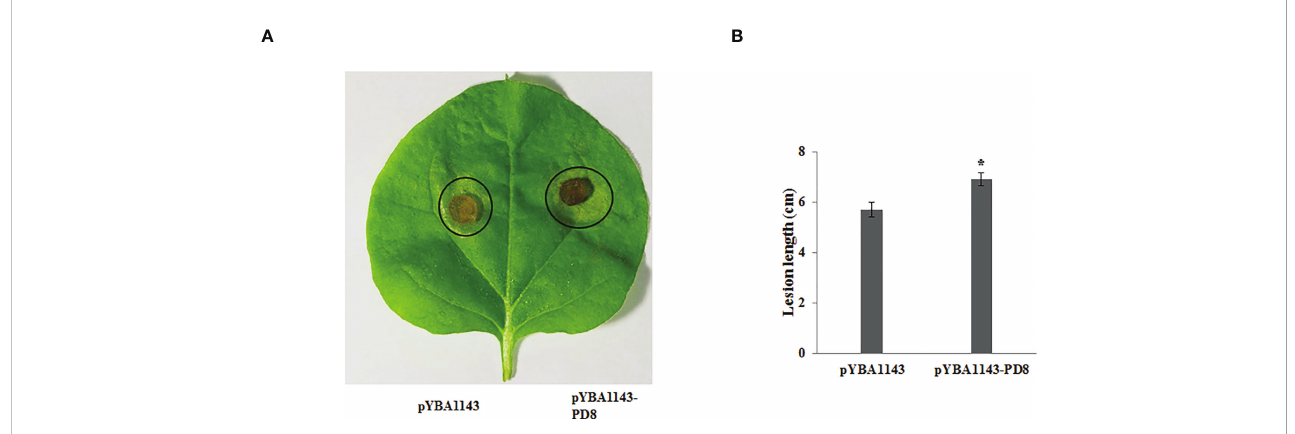
FIGURE 5 Over-expressing PD8 lead to enhanced susceptibility to R. solani . (A) The disease phenotypes (B) The lesion diameter of leaves infected by R. solani at 2